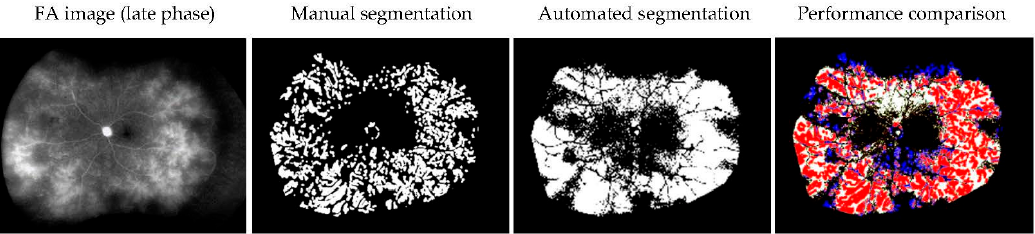
Figure 3. Comparison of manual and automated segmentation of the retinal vascular leakage area in a representative case (idiopathic uveitis). True positive: red. False negative: blue. False positive: white.